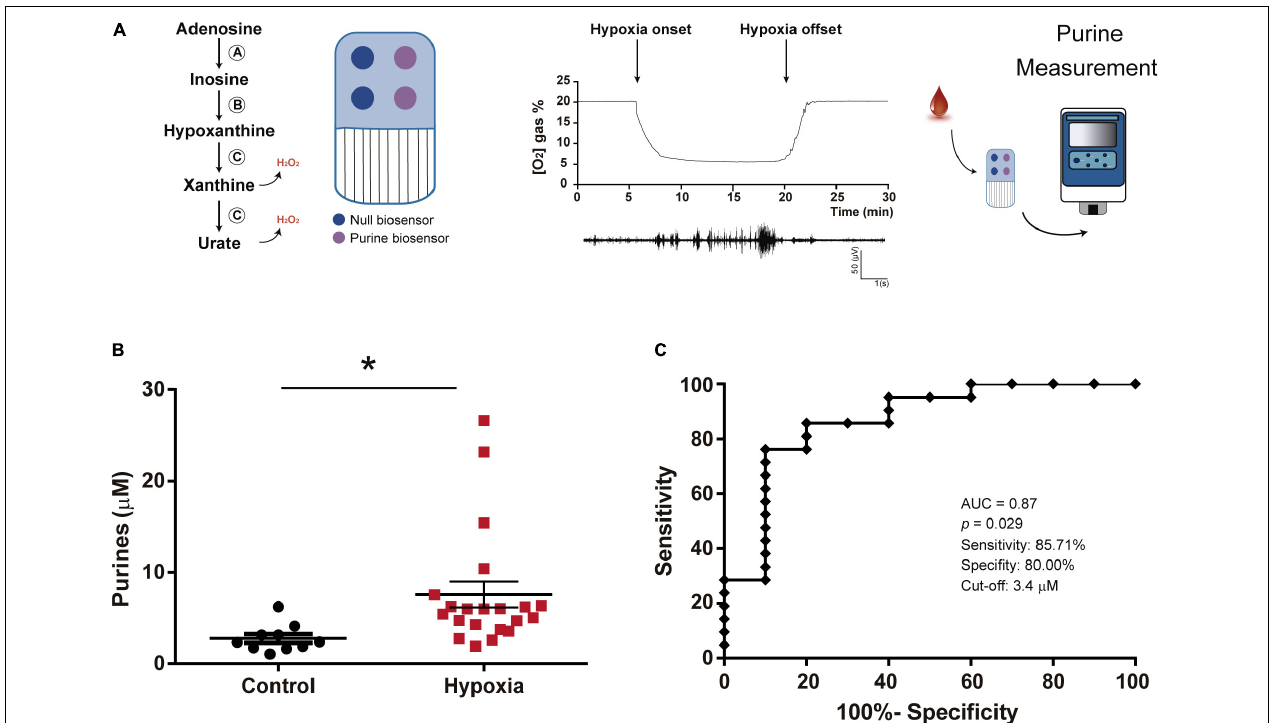
FIGURE 1 | Increased blood purine concentrations following hypoxia in mice. (A) Schematic outlining functioning of SAMRTChip and neonatal hypoxia model in mice. Blood purines are detected via an enzymatic cascade with enzymes entrapped within a layer on a Ruthenium Purple-coated gold electrode. This includes (A) Adenosine deaminase which converts adenosine into inosine, (B) Nucleoside phosphorylase which converts inosine into hypoxanthine and (C) Xanthine oxidase which converts hypoxanthine into xanthine and H 2 O 2 and subsequently xanthine into urate and H 2 O 2 . Each SMARTchip consists of two purine biosensors and two null biosensors. Final read is the difference between purine sensors subtracting the background measured via null sensors. P7 mice are subjected to 15 min of 5% O 2 experiencing hypoxia-induced seizures as detected via EEG recording. Blood purine concentrations were measured immediately following hypoxia using the SMARTChip. (B) Graph showing increased purine concentrations in blood post-hypoxia in mouse pups. Whole trunk blood samples were collected between 0 and 10 min post-hypoxia ( N = 10 control and 21 hypoxia), Unpaired Student’s t -test ( t = 2,296; df = 29; p = 0.029). (C) ROC analysis shows blood purine concentration had a 85.71% sensitivity, 80.00% specificity and AUC of 0.87 for identifying mice with hypoxia at a cut-off of 3.4 µ M ( N = 10 control and 21 hypoxia). * p <